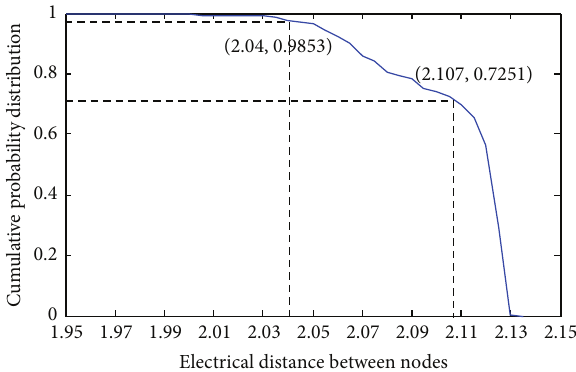
Figure 7: Cumulative Probability distribution of electrical distance between nodes in TJ220